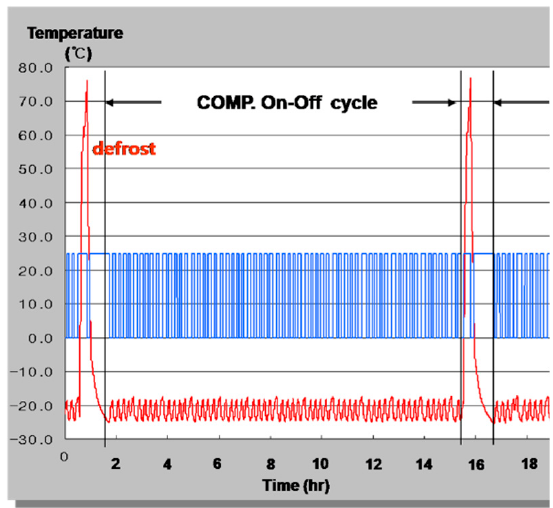
Figure 4. Compressor On/Off cycle for defrost state.